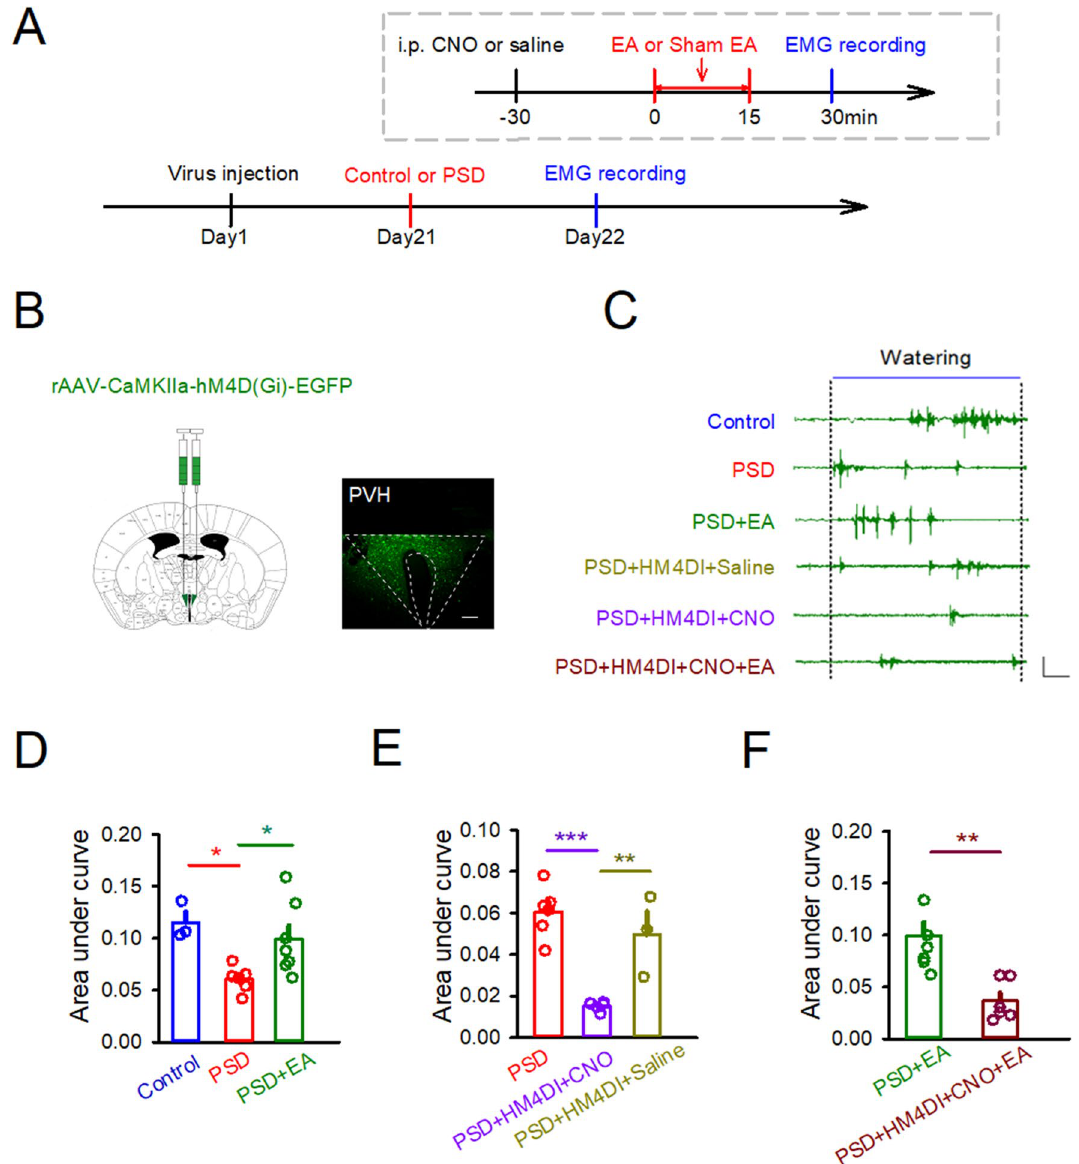
Figure 4. EA promoted the function of deglutition. ( A ) Schematics of experimental design. ( B ) Strategy to inhibit the PVH through inhibition of excitatory neurons. Shown is a representative image of HM4D in the PVH. Scale bars, 200 μm. ( C ) Changes in mylohyoid muscle electromyography (EMG) during a representative swallow. EMG of mylohyoid muscle in each group, Scale bars, time = 2 s, bin = 0.1mv. (D-F)The statistical analysis of the area under curve of EMG in every group. Data are shown as mean ± SEM (Control and PSD + HM4DI + Saline: N = 3 mice, PSD + HM4DI + CNO: N = 4 mice, PSD: N = 6 mice, PSD + EA: N = 7 mice, PSD + HM4DI + CNO + EA: N = 6 mice). ( D ) and ( E ) One-way ANOVA with Tukey’s multiple comparisons test. (F) Unpaired t test. * p < 0.05, ** p < 0.01, *** p <